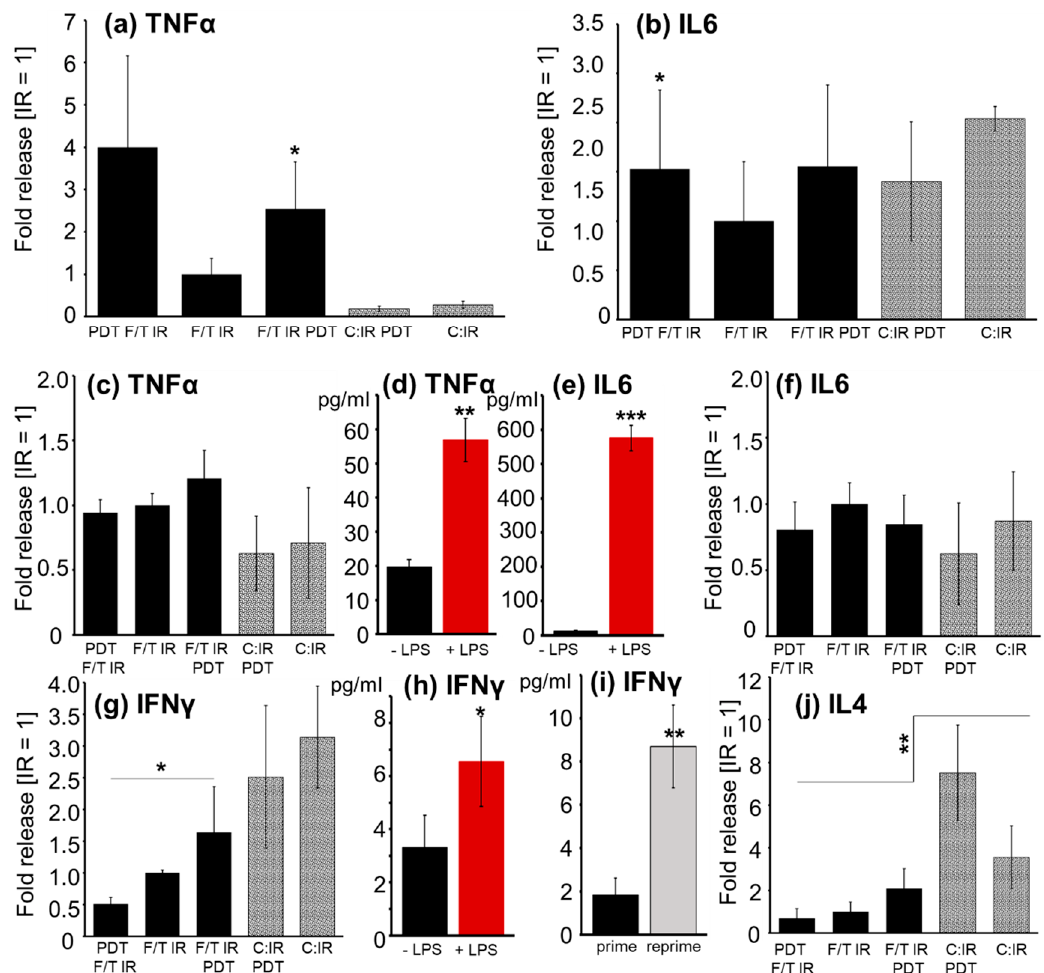
Figure 5. Cytokine release. Fold release represents relative values (IR = 1) ± SEM; otherwise mean ± SEM is given, n ≥ 3.TNF α ( a ) and IL6 ( b ) release of dendritic cells, 24 h after pulsing with different antigen preparations (PDT,F/T,IR, F/T,IR; F/T,IR, PDT): GL261 lysate (black bars); GL261 cells (dotted bars); *, p ≤ 0.05 relative to F/T IR treatment. TNF α ( c , d ) and IL6 ( e , f ) release by DC/T cells 24–72 h after priming of T cells with DCs; ( c , f ) Effect of antigen preparation; ( d , e )